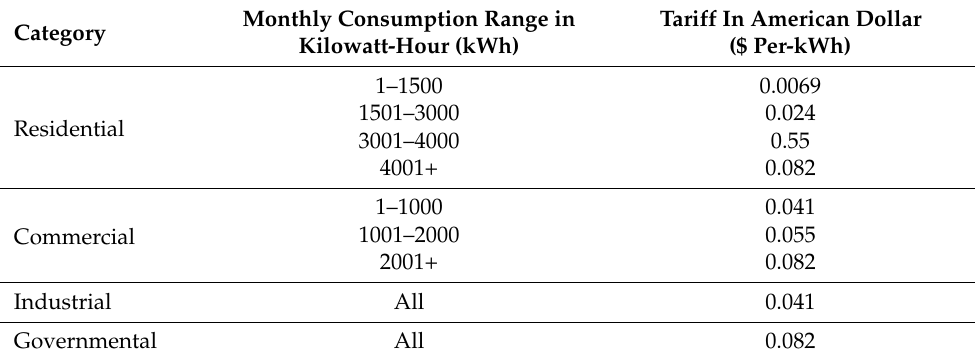
Table 1. Summary of electricity tariffs in Iraq in 2018 [39].